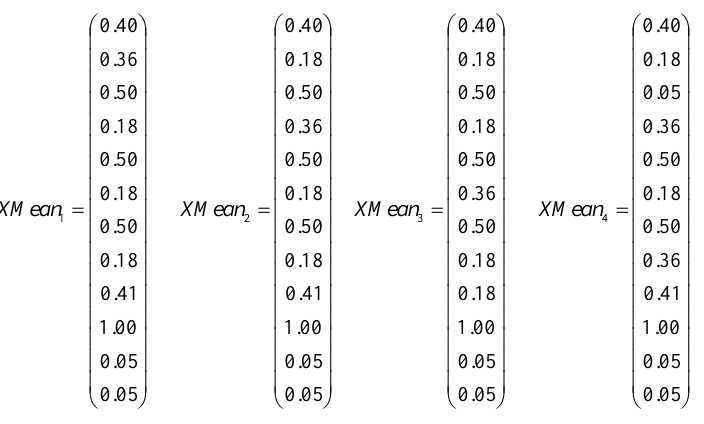
Table 6. Final linguistic labels for the output variables in the district Barra Output variable score o 1 o 2 o 3 o 4